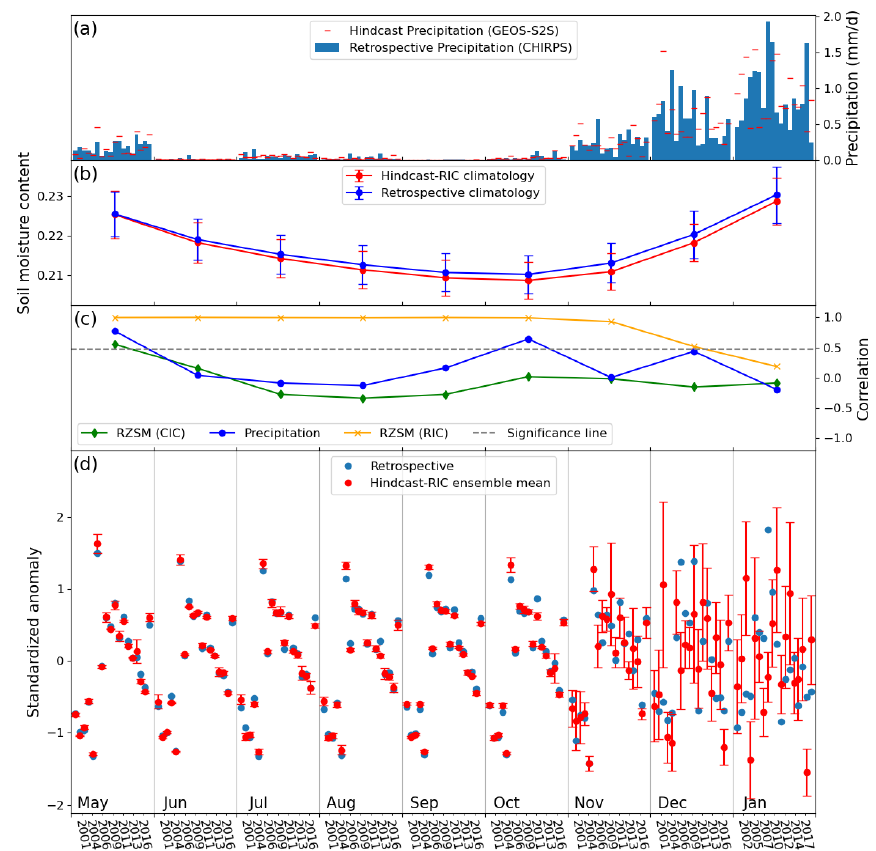
Figure 6. Same as Fig. 4, but for the Helmand